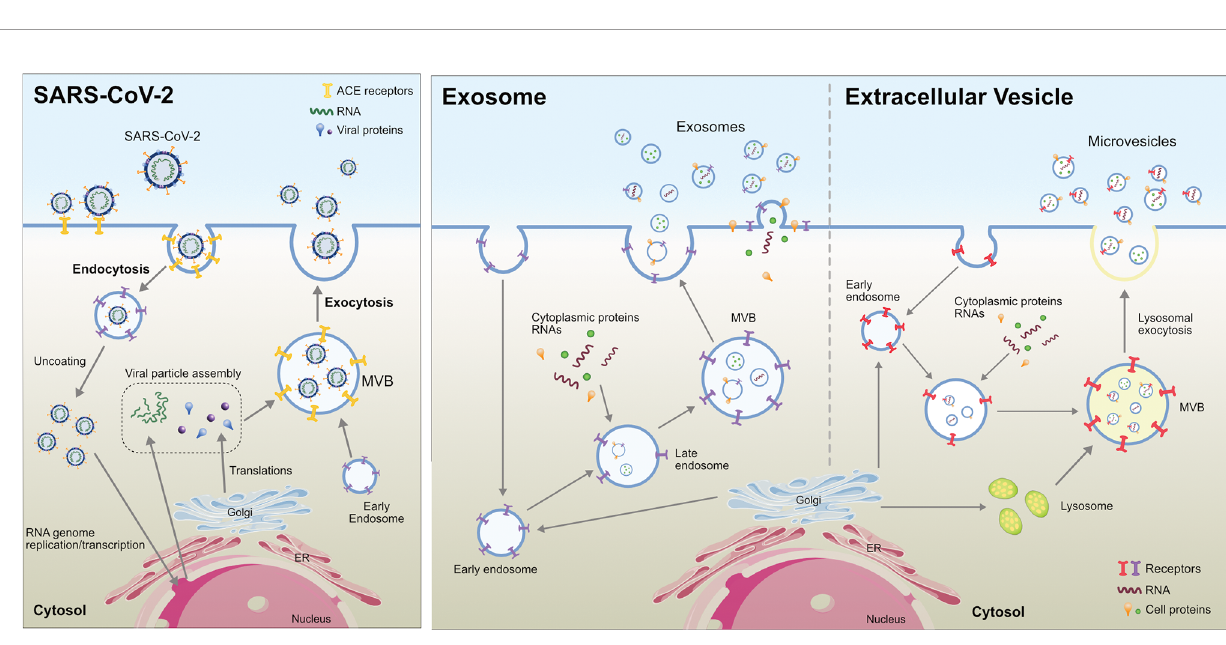
FIGURE 2 | Comparison between Extracellular Vesicle, Exosome and virion biogenesis at the plasma membrane in eukaryotic